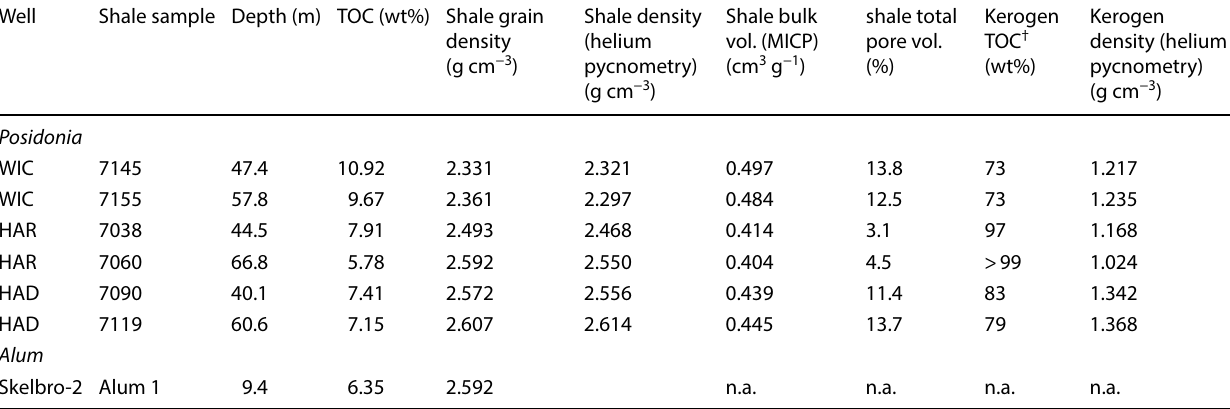
n.a. not available † The kerogen TOC content is corrected for the residual pyrite content, which could not be removed by the separation